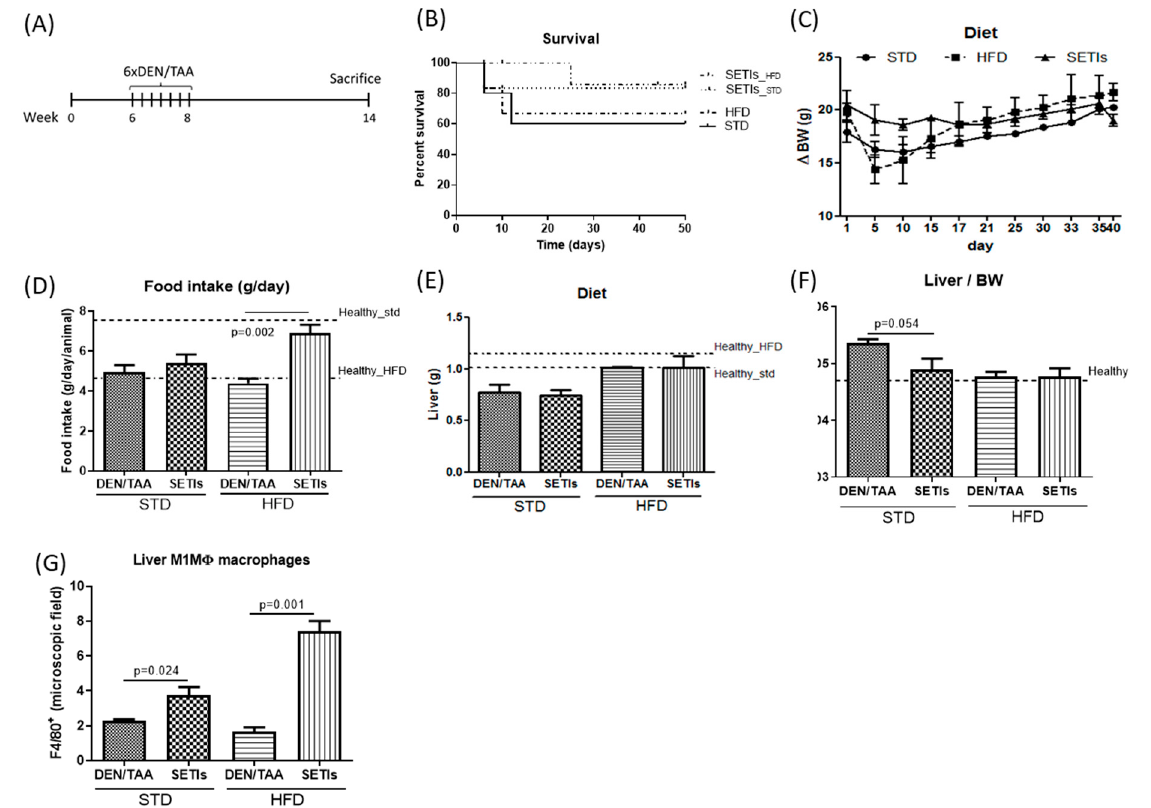
Figure 1. Liver tumor development in mice administered diethylnitrosamine (DEN) and the hepatotoxin thioacetamide (TAA). ( A ) Schematic representation of the procedure to induce the hepatocarcinoma in mice fed with a standard diet (STD) or a high-fat diet (HFD). ( B ) Survival curve (days) of serine-type protease inhibitors (SETIs) administered to mice fed with a standard diet (STD) or a high-fat diet (HFD). ( C ) Body weight gain of mice fed an STD or HFD, and those fed an HFD and administered SETIs were measured over 7 weeks. ( D ) Food intake in STD- or HFD-fed mice, receiving or not receiving SETIs, was measured every 48 h during the study period. ( E ) Liver masses in STD- or HFD-fed mice, receiving or not receiving SETIs, measured at week 7. ( F ) Liver to body weight (BW) ratio of DEN/TAA-treated mice fed with STPIs. ( G ) The number of infiltrated F4/80 + macrophages in hepatic tissues of STD- and HFD-fed mice receiving or not receiving SETIs was determined at week 7 after first DEN/TAA administration. Results are expressed as mean ± mean standard error (SEM) ( n = 6).